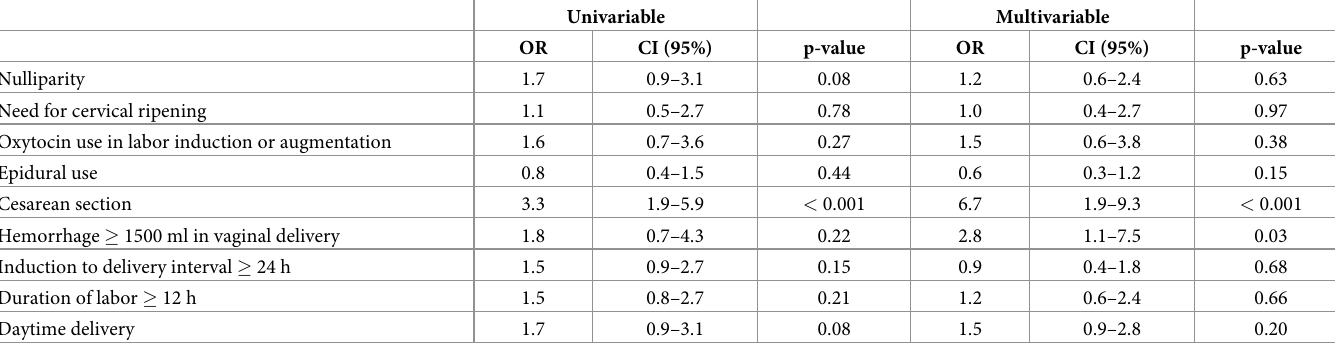
Table 5. Factors associated with a negative childbirth experience (n = 52;